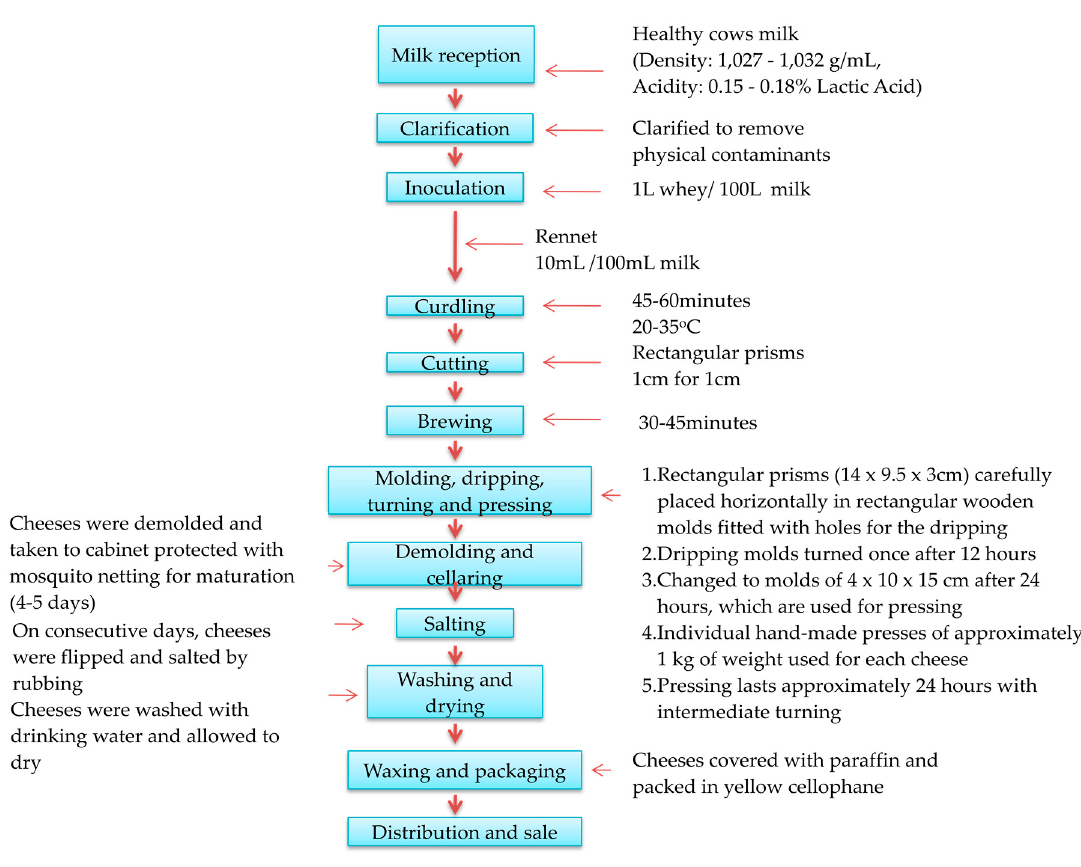
Figure 1. Flowchart for Poro cheese making process.